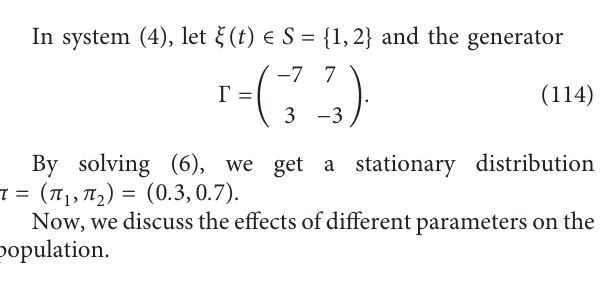
Figure 2: Effect of the white noise: (a) σ ( 1 ) � 0 . 2 , σ ( 2 ) � 0 . 2; (b) σ ( 1 ) � 0 . 5 , σ ( 2 ) � 0 . 5; (c) σ ( 1 ) � 1 , σ ( 2 ) �